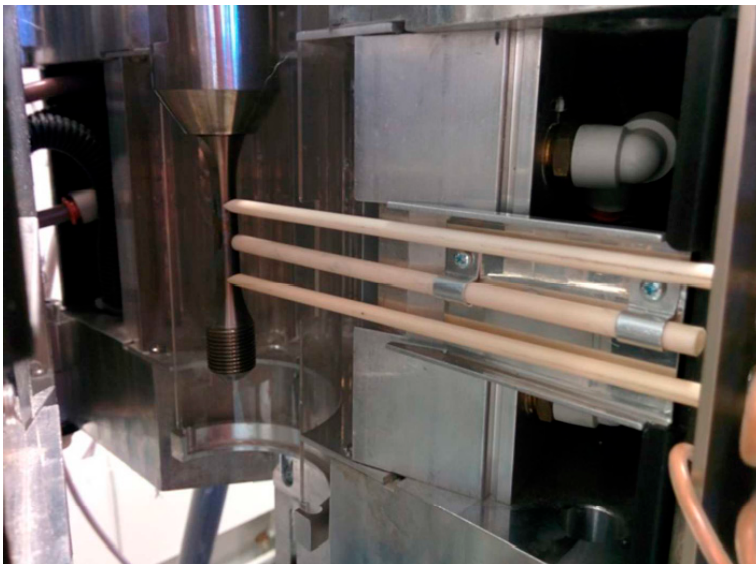
Figure 2. Close proximity thermocouple mount, allowing for more direct temperature readings to be made from the gauge length and hence derive a consistent relationship with the specimen surface temperature.